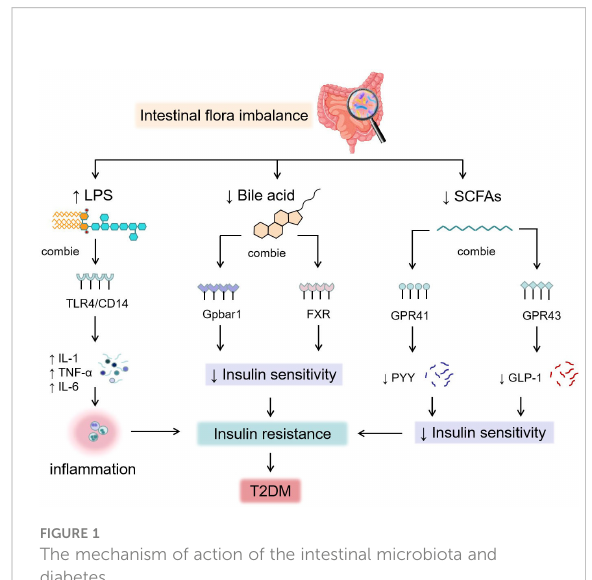
FIGURE 1 The mechanism of action of the intestinal microbiota and